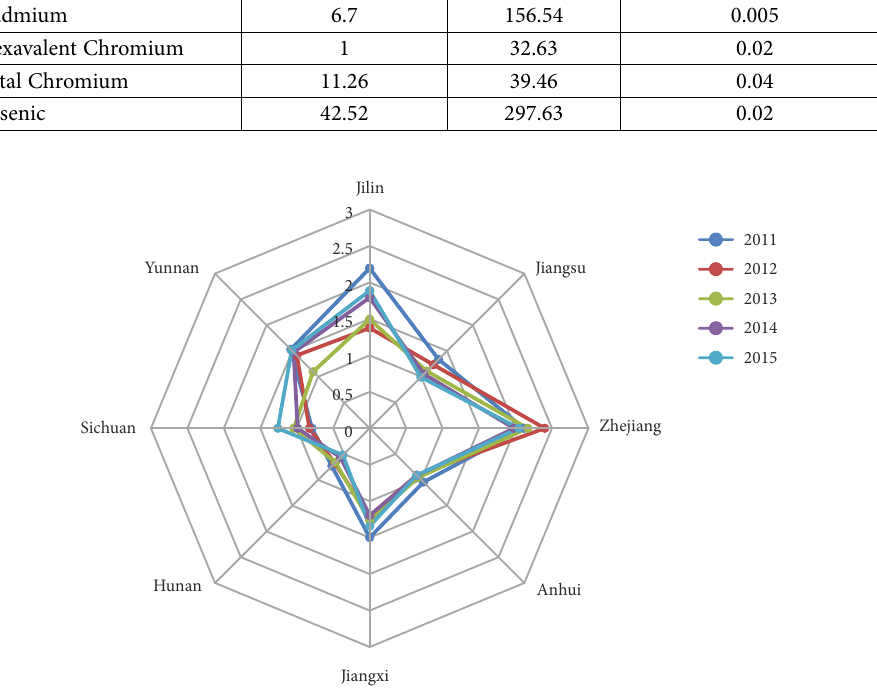
Figure 10. Average sewage